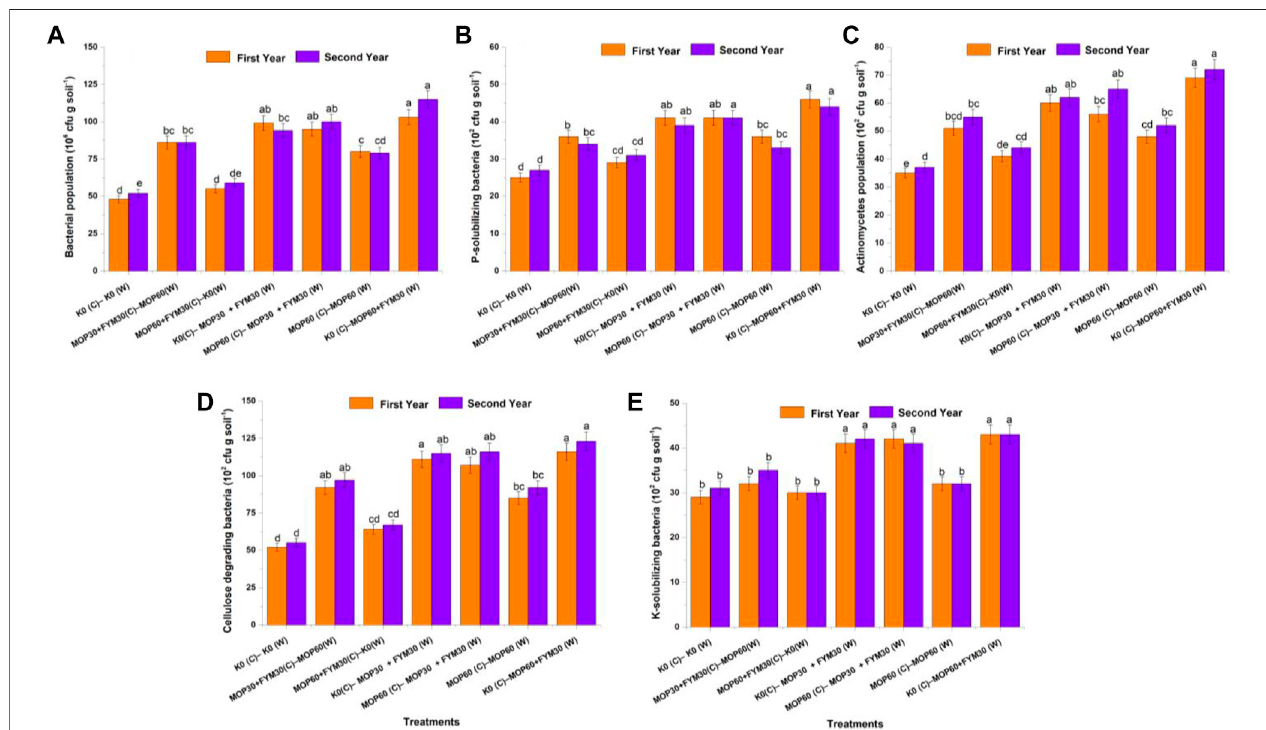
FIGURE 1 | Effect of integrated K application on microbial population count among treatments: bacterial population (A) ; P-solubilizing bacteria (B) ; actinomycetes (C) ; cellulose-degrading bacteria (D) ; and K-solubilizing bacteria (E) .